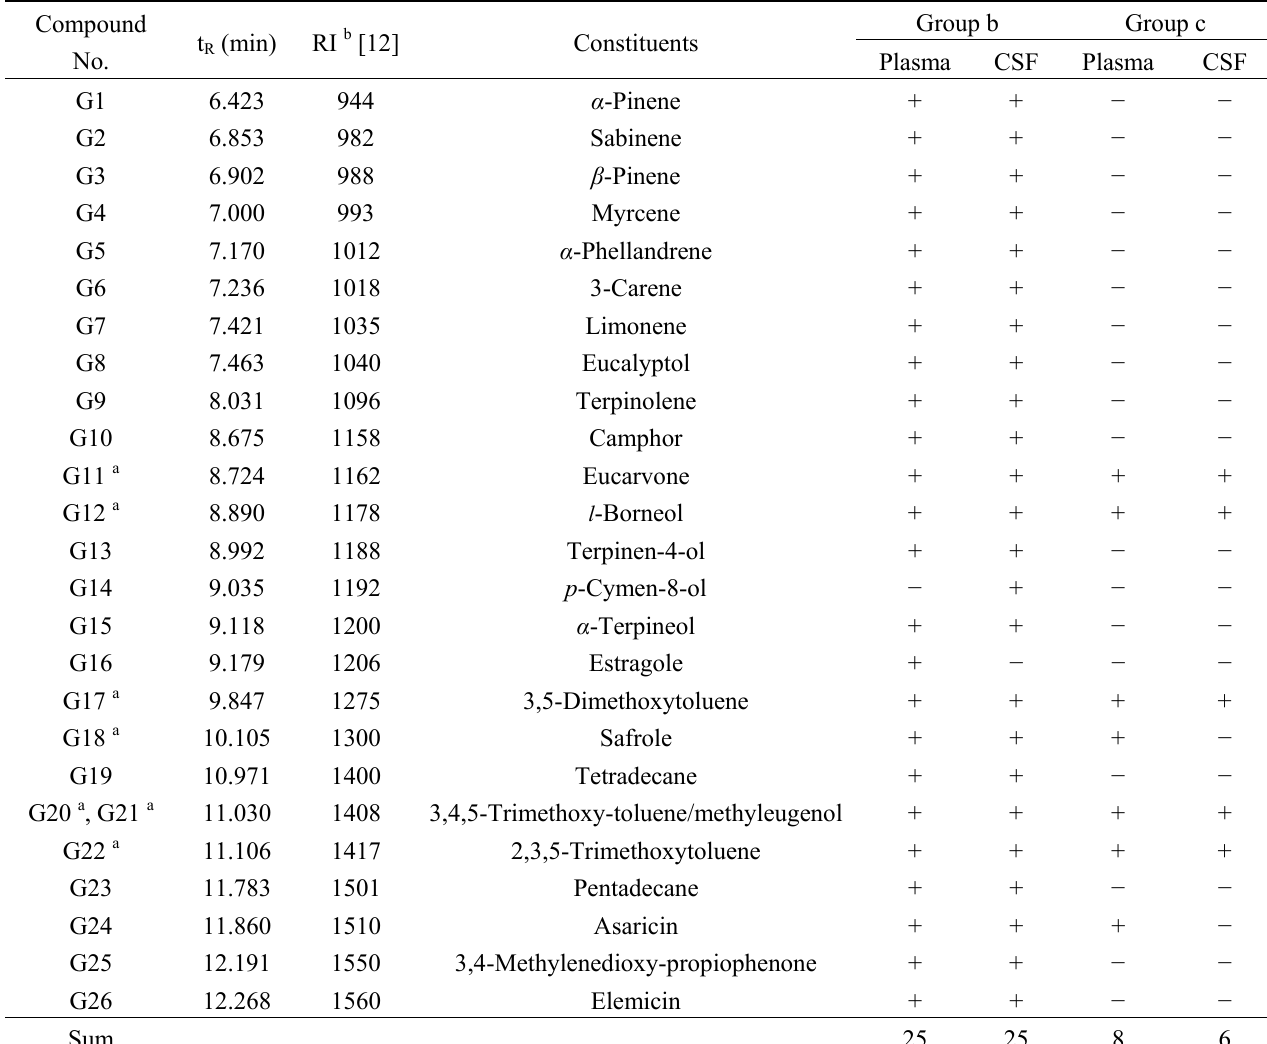
Table 1. The absorbed constituents in rabbit plasma and cerebrospinal fluid (CSF) from Asari Radix et Rhizoma (AR) EtOAc extract group (group b ) and AR powder group (group c ) identified by